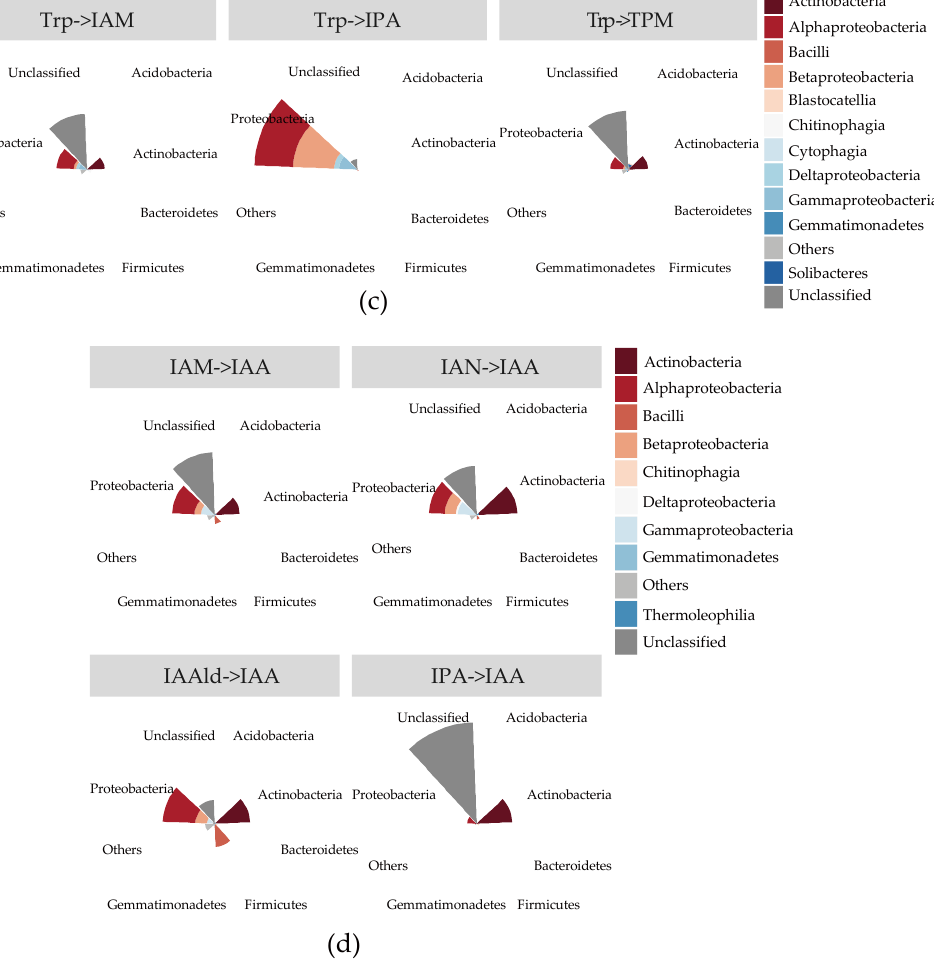
Figure 3. Quantification of the IAA synthesis related genes in root environments. The bar plots show the relative abundance of ( a ) Trp-catalyzing enzymes and ( b ) enzymes in the last step of IAA synthesis in rhizosphere (RS) and rhizoplane (RP), respectively. ( c ) and ( d ) represent the taxonomic structures of Trp-catalyzing enzymes and IAA synthesis enzymes, respectively.